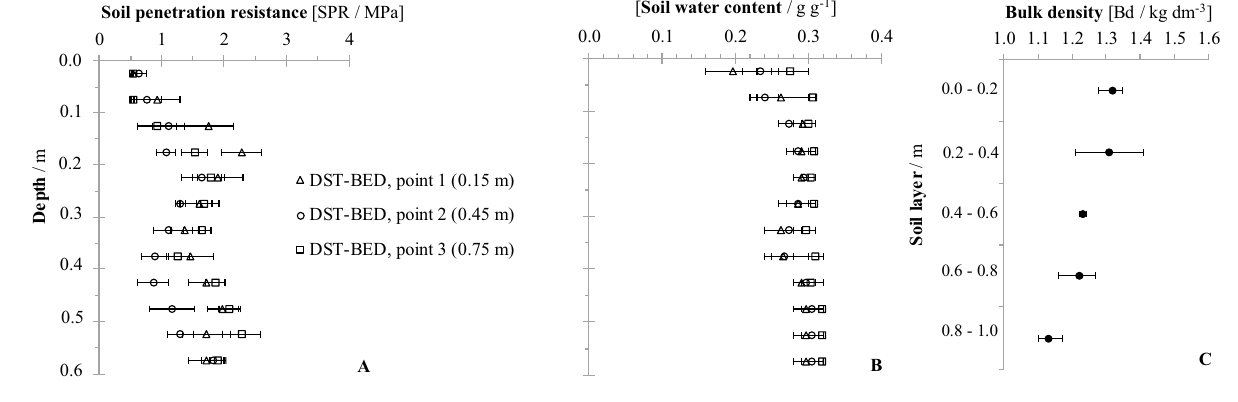
Figure 3. Soil penetration resistance ( A ) and soil water content ( B ) for deep strip tillage bed with no traffic (DST-BED) at three sampling positions (0.15, 0.45 and 0.75 m from planting row), and the average bulk density ( C ) at point 2. If confidence intervals do not overlap, the differences are significant (p ≤ 0.15).